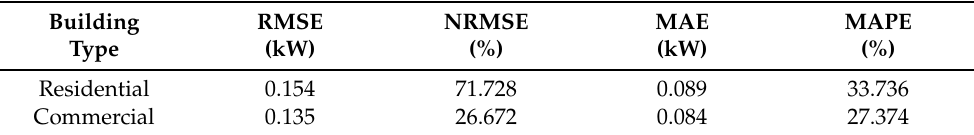
Table 5. Performance of aggregated forecasting for different buildings types in the period April to